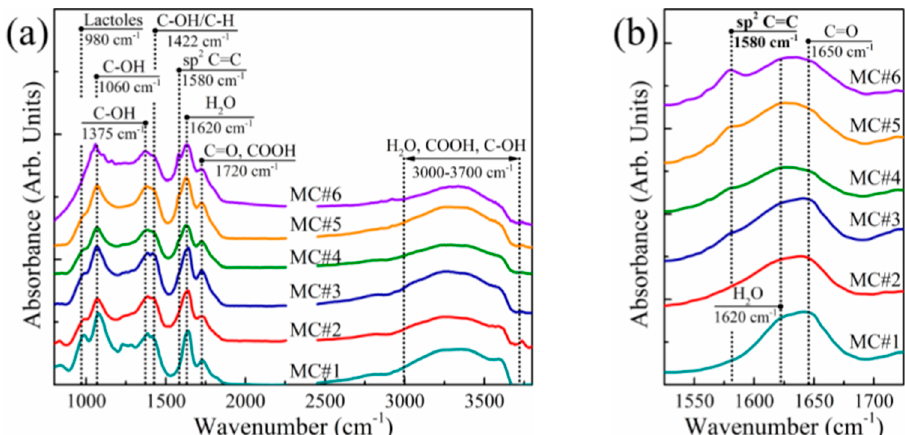
Figure 1. ( a ) Survey and ( b ) enlarged at 1520–1720 cm − 1 FTIR spectra of the MC#1–MC#6 films. The spectra are vertically offset for clarity.